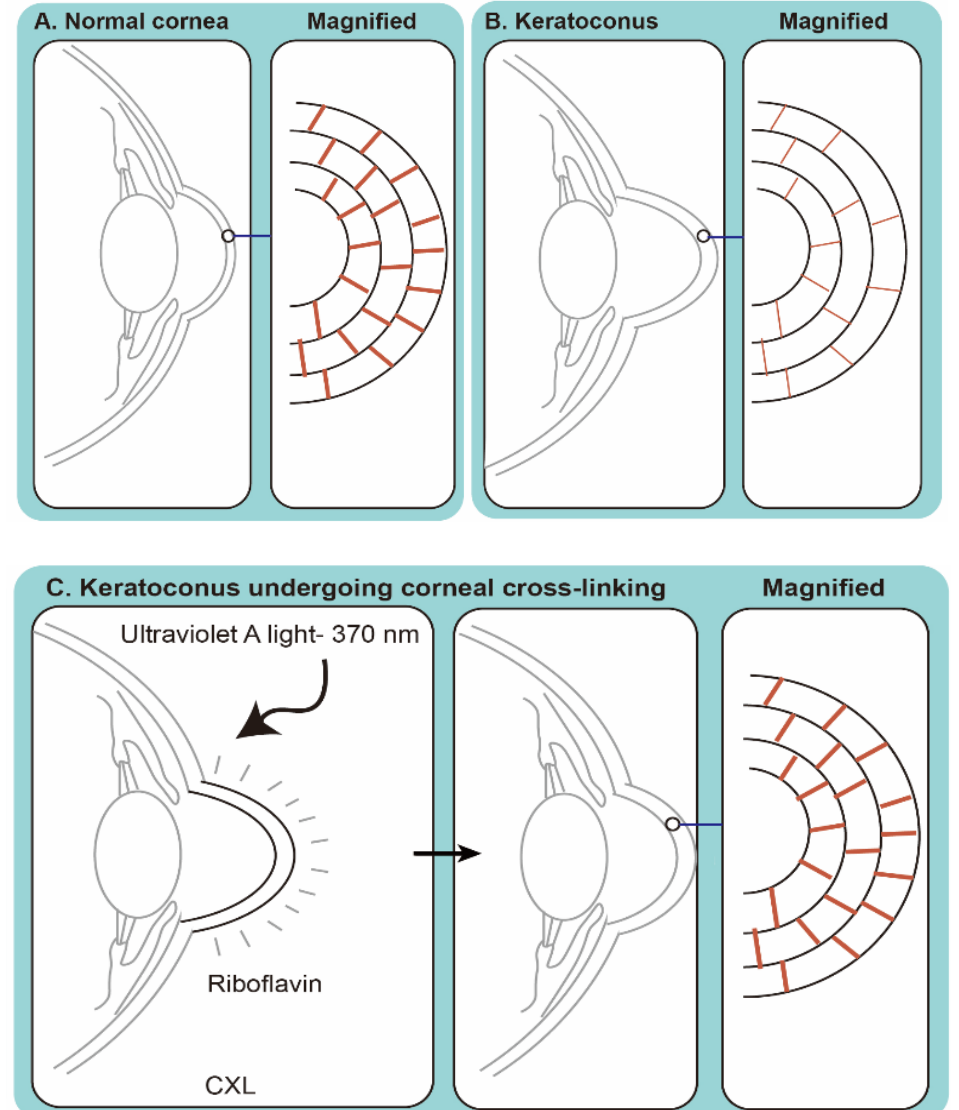
Figure 4. Schematic drawing of corneal crosslinking (CXL) using riboflavin as a photosensitizer and activated with UVA. ( A ) A normal corneal contour. The magnified view of the corneal stroma showed normal amount of the corneal cross-links. ( B ) Keratoconus represents a corneal disorder where central or paracentral cornea undergoes progressive thinning and steepening. Magnified view of the corneal stroma showed less cross-link bonds within the extracellular matrix of the stromal collagen (red bars). ( C ) Upon exposure of riboflavin to UV-A light, the number of covalent bonds between collagen molecules, and between collagen molecules and proteoglycans increased leading to the stiffening of the cornea. The PDT effects is mediated primarily through the generation of singlet oxygen.